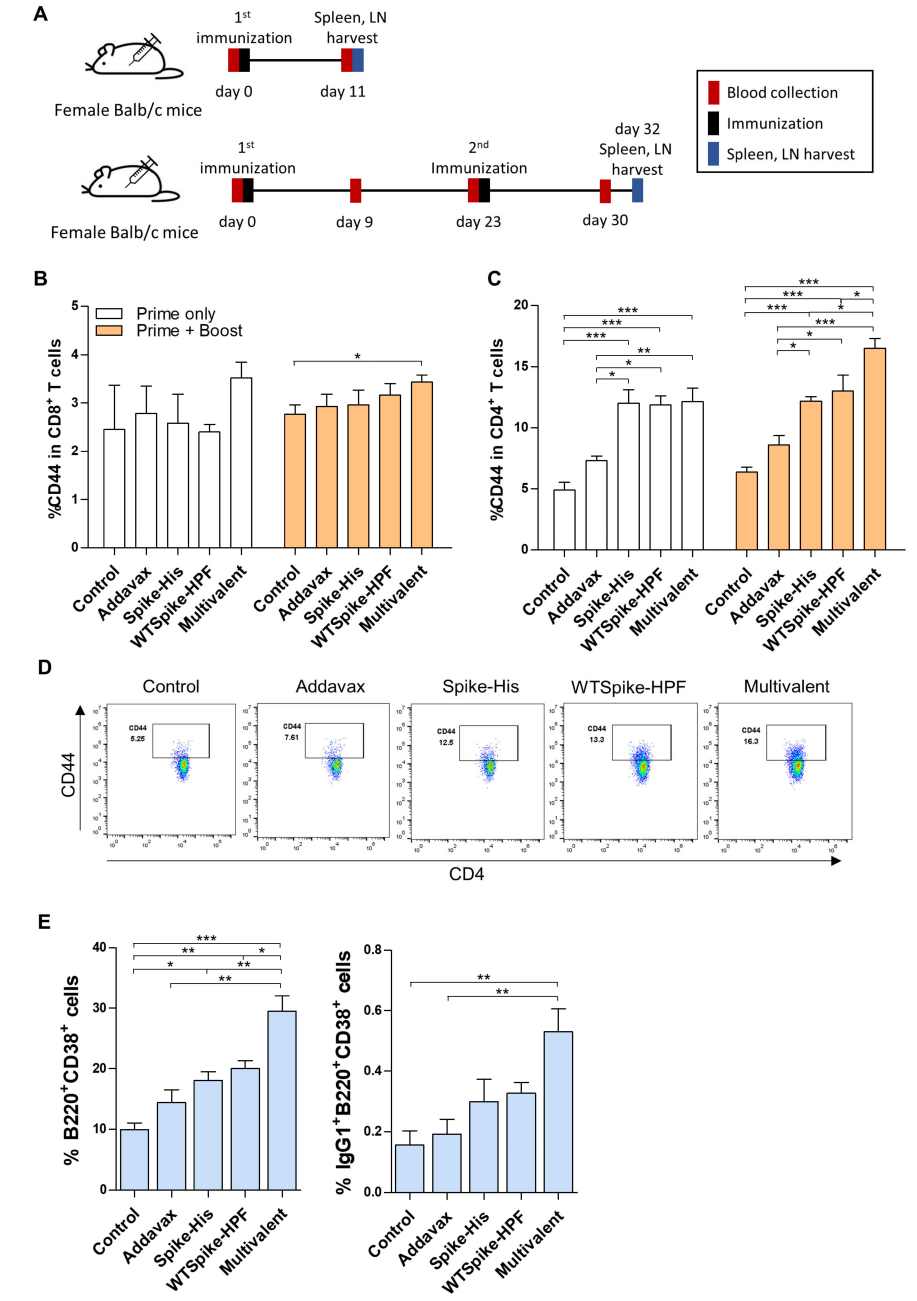
Figure 2. Evaluation of immune responses post-multivalent spike-HPF vaccine